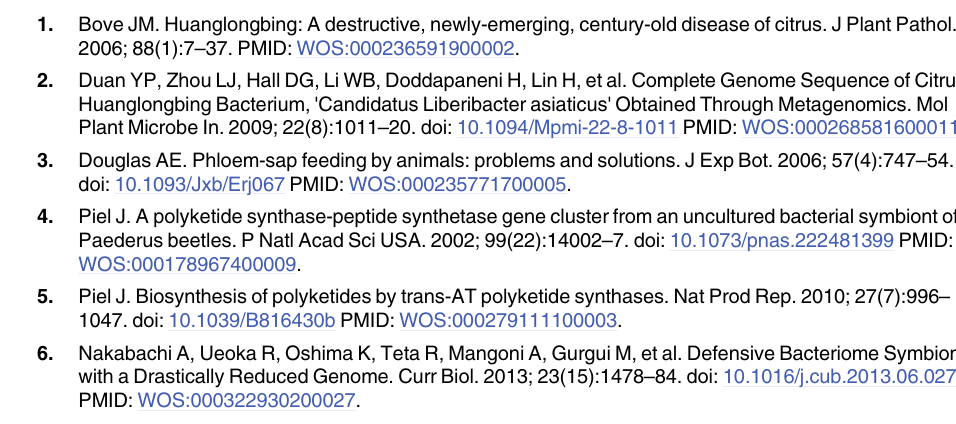
S7 Table. D. citri proteins identified as down-regulated in CLas(+) Percoll fractions. Aver- age normalized spectral count (N = 3) for protein samples from CLas(+) and CLas(-) D. citri Percoll fractions. Fold difference CLas(+)/CLas(-). Thresholds for protein differential expres- sion: Ttest p-value < = 0.05, fold difference > = 2. S8 Table. Scaffold output of mascot data from Percoll fraction peptide mass spectra. Nor- malized peptide spectral count numbers for all proteins identified in Percoll fraction samples. Fold difference: CLas(+) average/CLas(-) average. S9 Table. Scaffold peptide report for Percoll fraction analysis. Peptide sequences and protein IDs, and peptide and protein probability scores. Spectral count data for each peptide, including exclusive unique peptide count, exclusive unique spectrum count, and percentage protein sequence